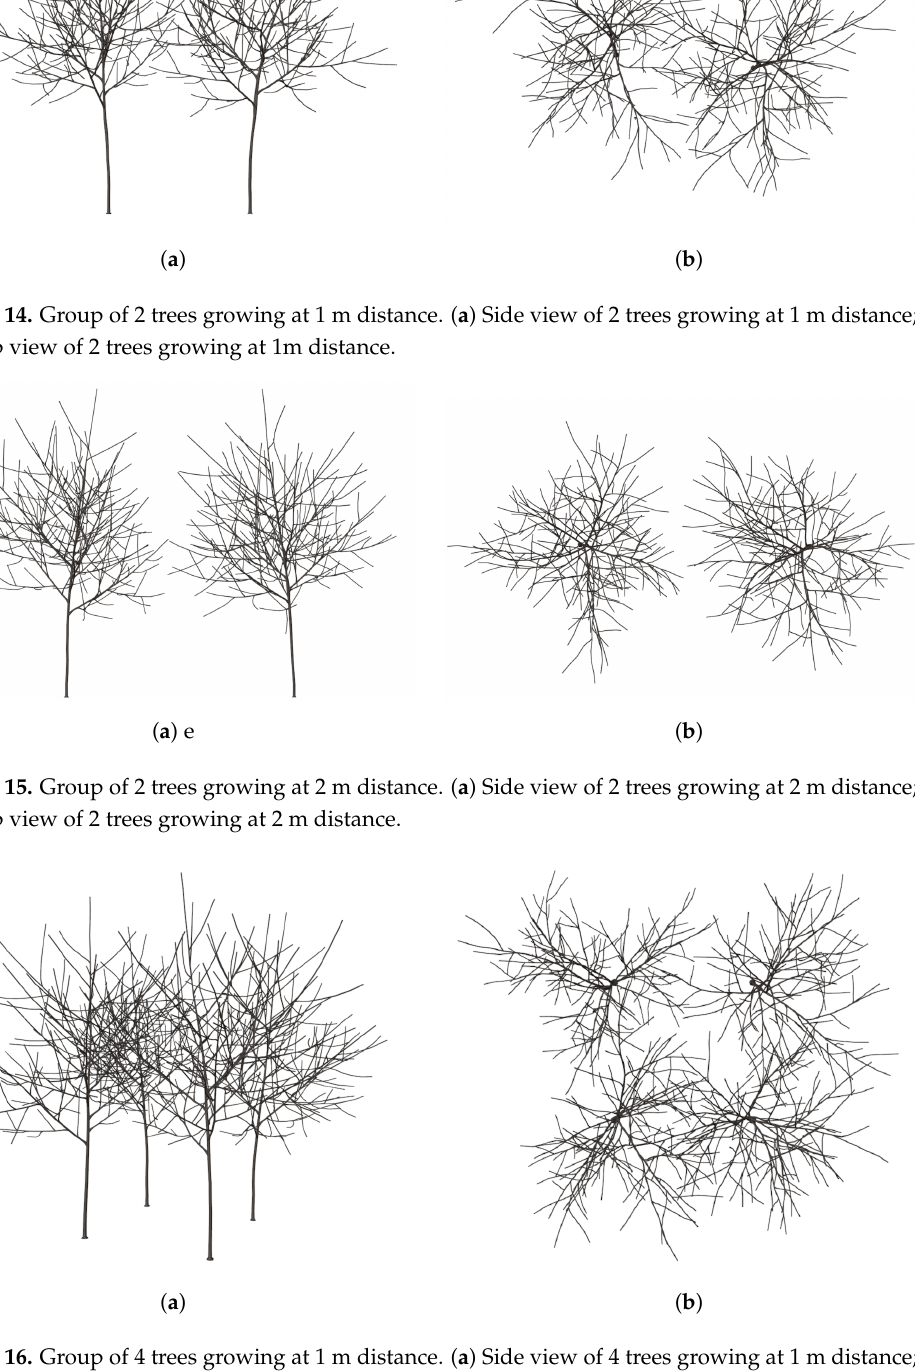
Figure 16. Group of 4 trees growing at 1 m distance. ( a ) Side view of 4 trees growing at 1 m distance; ( b ) Top view of 4 trees growing at 1 m